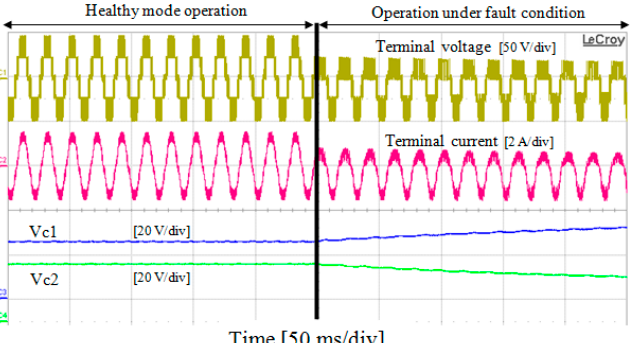
Figure 13. Experimental results of the inverter operation under fault event in S 11 without fault-tolerant control.